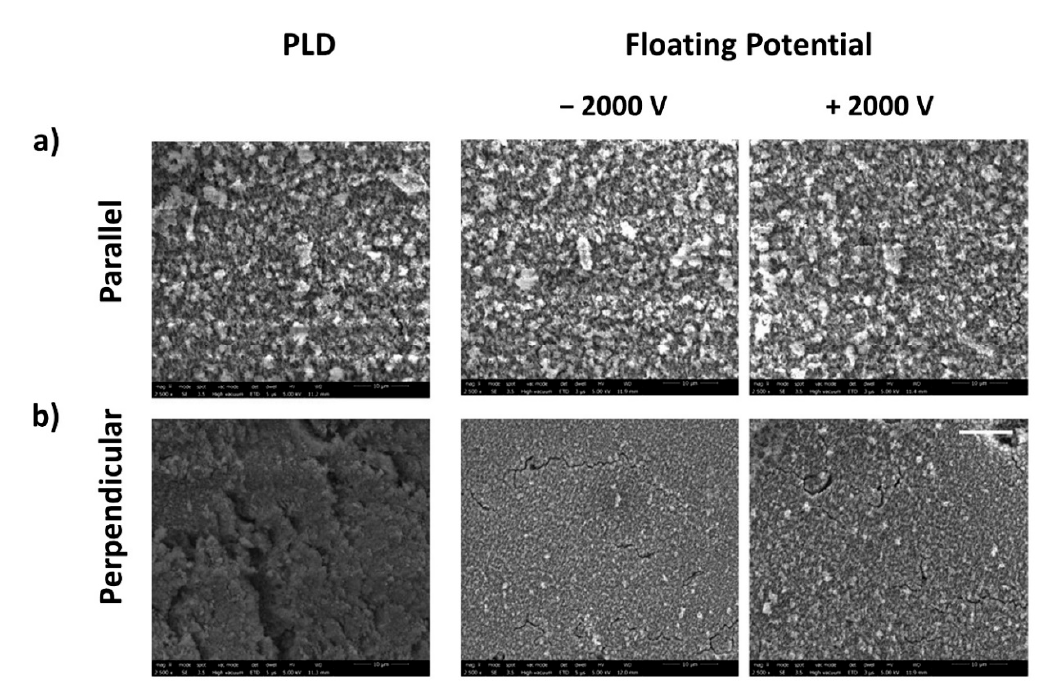
Figure 8. SEM images of Ti surfaces laser micromachined in the ( a ) parallel and ( b ) perpendicular laser scanning directions. The white scale bar corresponds to 10 µm and applies to all images.